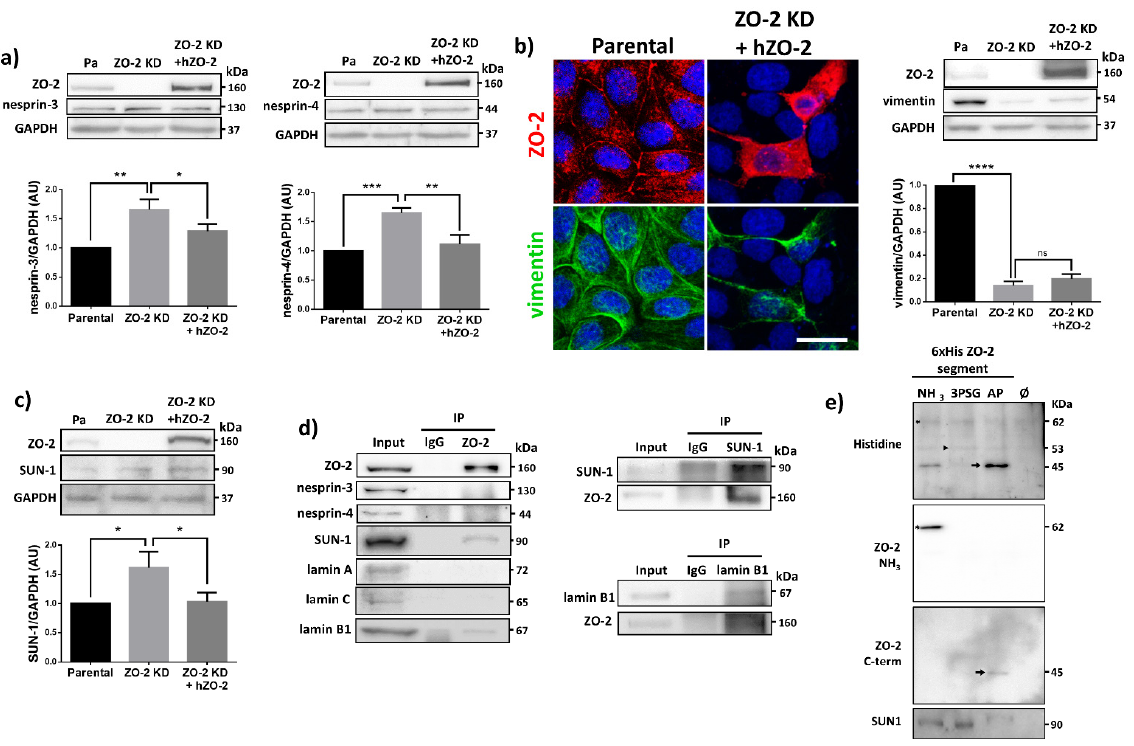
Figure 7. ZO-2 associates to SUN-1 and lamin B1, and its absence triggers an increased expression of SUN-1 and nesprins-3, and -4 and reduces vimentin. ( a ) Western blot detection of nesprins-3 and -4 in parental and ZO-2 KD cells transfected or not with hZO-2. Upper panels, representative images; lower panels, quantitative analysis obtained from three independent experiments. GAPDH is used as a loading control. Statistical analysis was done with One-way ANOVA followed by Tukey’s multiple comparisons test. Results shown as media ± standard deviation, * p < 0.05, ** p < 0.01, *** p < 0.001. ( b ) Left panel, representative immunofluorescence images showing ZO-2 and vimentin expression in parental and ZO-2 KD cells transfected or not with hZO-2. Bar, 20 μ m. Right panel, representative Western blot of three independent experiments and corresponding quantitative analysis. GAPDH is used as a loading control. Statistical analysis was done with One-way ANOVA followed by Tukey’s multiple comparisons test. Results are shown as media ± standard deviation, **** p < 0.0001; ns, non-significant. ( c ) Western blot detection of SUN-1 in parental and ZO-2 KD cells transfected or not with hZO-2. Upper panel, representative image; lower panel, quantitative analysis obtained from three independent experiments. GAPDH is used as a loading control. Statistical analysis was done with One-way ANOVA followed by Tukey’s multiple comparisons test. Results are shown as media ± standard deviation, * p < 0.05. ( d ) Left column, immunoprecipitation of ZO-2 from sparse MDCK cells followed by Western blot detection of ZO-2, nesprins-3 and -4, SUN-1, and lamins A, C and B1. Right panels, immunoprecipitation of SUN-1 and lamin B1 from sparse MDCK cells followed by Western blot detection of ZO-2, SUN-1, and lamin B1. Representative image from three independent experiments. ( e ) 6xHis-tagged amino (NH3), 3PSG and AP segments of cZO-2 and the empty vector ( Φ , negative control) were purified with Ni affinity columns from extracts of HEK293T cells, run in SDS-PAGE and blotted with antibodies against the histidine tag, the amino and C-terminal portion of ZO-2, or pulled-down SUN-1 protein. Upper panel, * band of 61 kDa of amino ZO-2 segment; full arrowhead, band of 53 kDa of 3PSG ZO-2 segment; full arrow, band of 45 kDa of AP ZO-2 segment. Second panel from top, * band of 61 kDa of amino ZO-2 segment. Third panel from top, full arrow, band of 45 kDa of AP ZO-2 segment. Lower panel, anti SUN-1 antibody gives a positive signal in pull-downs of amino and 3PSG segments of cZO-2.